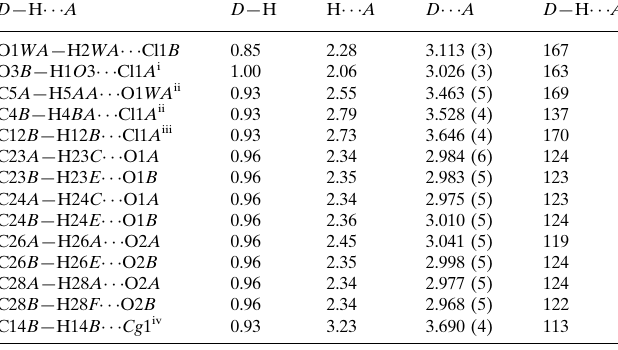
Hydrogen-bond geometry (A˚ , (cid:2) ). D —H (cid:1)(cid:1)(cid:1)